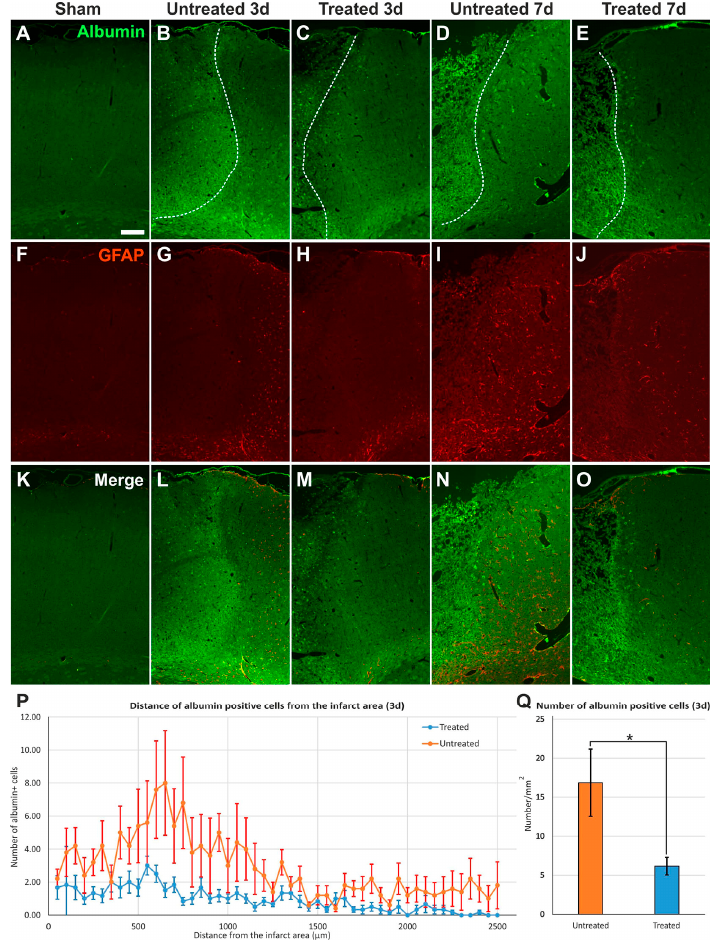
Figure 2. Albumin infiltration in perilesional cortex. ( A – O ) Immunostaining for endogenous rat albumin reveals infiltration in infarct areas and cellular silhouettes in the surrounding parenchyma, apparently more in untreated animals than in TGN-020-treated rats, and overall, reduced gliosis in treated animals compared to untreated animals; ( P ) Distance frequency distribution of albumin-positive cellular silhouettes shows more frequent elements for the untreated animals around the infarct, with a peak at 500–1000 µm from the necrotic tissue (Student’s t -test, p < 0.001), at 3 days; ( Q ) The total number of albumin-positive cells quantified in ( P ) shows a significantly higher density for untreated rats (Student’s t -test, p < 0.05). Data are expressed as the means ± SEM. The dotted lines delineate the infarct cores on the left side in images B – E . Scale bars in the micrographs represent 200 µm. * p < 0.05